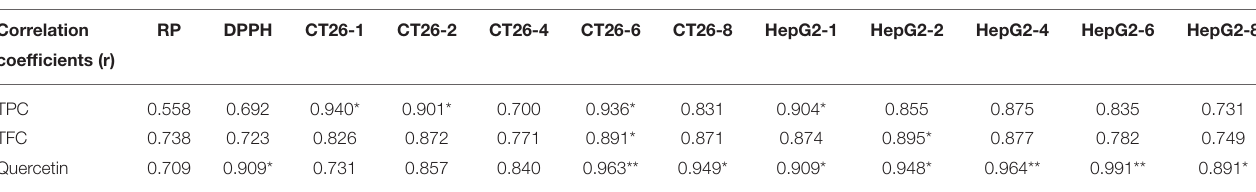
TABLE 2 | Correlation coefficients of phytochemicals and bioactivities of